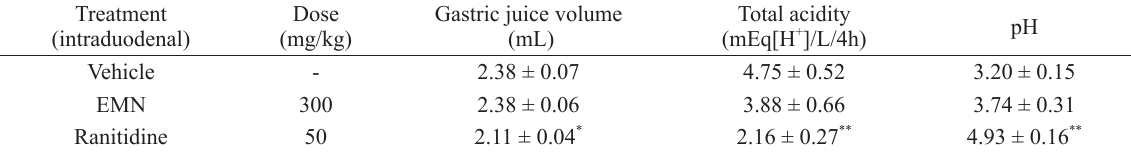
Effects of ethanolic root extract of Memora nodosa (EMN) on gastric juice parameters in mice after pylorus ligature. Treatment (intraduodenal)